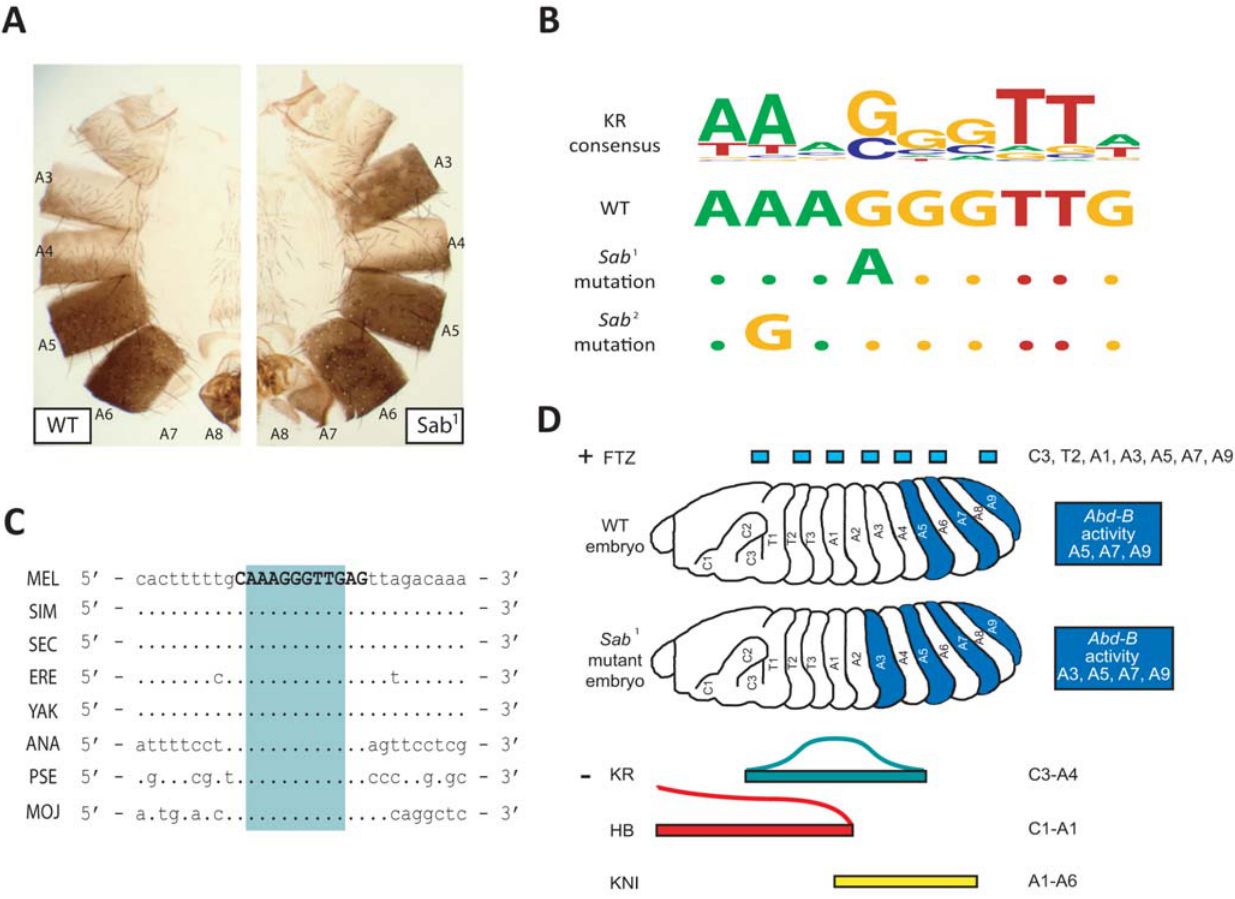
Figure 5. A single point mutation in a bioinformatically predicted KRUPPEL TFBS in the IAB5 enhancer CRM causes ectopic activation of Abd-B and a homeotic transformation in Superabdominal mutant embryos. (A) Sab homeotic mutant phenotype. In wild-type adult male flies the abdominal segments A5, A6, A7, and A8 exhibit dark pigmentation. In the Sab 1 mutant, abdominal segment A3, but not A4, exhibits additional dark pigmentation, suggesting a transformation towards an A5-like identity. The Sab 2 homeotic mutant exhibits a similar phenotype to Sab 1 , although it has only been examined as a double mutant with Mcp . (B) Identification of single point mutation in the only high- scoring predicted KRUPPEL binding site in the IAB5 enhancer CRM. The IAB5 enhancer in Sab 1 mutants contains a single G to A substitution at base 104543 in the U31961 genomic sequence, with no additional changes in the 1027bp IAB5 region. The IAB5 enhancer in Sab 2 mutants contains a single A to G transition at base 104541 in the U31961 genomic sequencing, with no additional changes in the 1027 bp region. The Sab 1 and Sab 2 point mutations are in the fourth and second position, respectively, of the highest scoring predicted KRUPPEL binding site in the IAB5 enhancer. Each significantly lowers the affinity of KRUPPEL binding, as predicted by the KRUPPEL consensus binding sequence. (C) High-scoring KRUPPEL site in IAB5 is conserved across 11 Drosophila species. The IAB5 orthologous sequences from D. melanogaster (MEL), D. simulans (SIM), D. sechellia (SEC), D. erecta (ERE), D. yakuba (YAK), D. ananassae (ANA), D. pseudoobscura (PSE), D. persimilis (data not shown), D. virilis , (data not shown), D. mojavensis (MOJ) and D. grimshawi (data not shown) were compared by simple sequence alignment. The bioinformatically predicted high-scoring KRUPPEL binding site in the IAB5 CRM in D. melanogaster is 100% conserved in all these species (teal box), while the neighboring sequence does not share this high level of conservation, particularly in more distantly related species. (D) Abdominal-B activity in wild-type and Sab mutant embryos. The embryonic domains of expression for the IAB5 activator, FTZ (blue) and repressors KR (teal), KNI (yellow) and HB (red) in wild-type and Sab mutants are indicated. The presumptive abdominal segments in which Abdominal-B ( Abd-B ) is activated by the IAB5 CRM are shown in dark blue. In the wild-type embryo Abd-B is active in A5, A7, and A9. Abd-B is not active in even numbered presumptive abdominal segments (A2, A4, A6, and A8), due to the absence of the FTZ activator. In addition, IAB5-directed expression of Abd-B is repressed in A1, A3, and more anterior segments due to binding of the combination of the KR, KNI and HB repressor factors. In the Sab 1 and Sab 2 mutation, disruption of the single highest scoring KRUPPEL binding site in the IAB5 CRM prevents KRUPPEL binding and facilitates ectopic activation of Abd-B in A3 (see Discussion for more details). construct with the IAB5 CRM harboring the Sab 1 or Sab 2 mutation (Figure 6A). In contrast to the wild-type (WT) IAB5 CRM, which drives reporter gene expression in the fifth, seventh, and ninth abdominal segments, the Sab mutant IAB5 CRMs drive ectopic expression in three distinct additional anterior stripes of lacZ (Figure 6B) and white (data not shown). The ectopic anterior stripes of expression driven by the Sab mutant IAB5 CRMs observed in Stage 5 and Stage 9 correspond to the second thoracic (T2), first (A1) and third (A3) abdominal segments and overlap with the